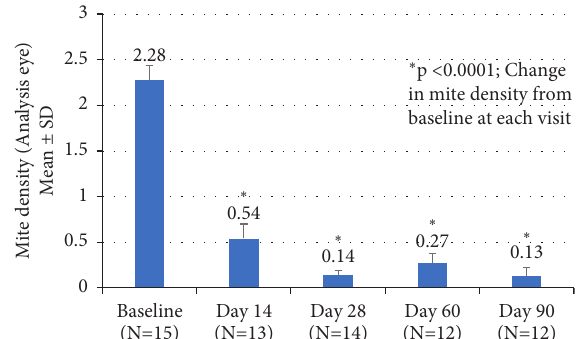
Figure 4: Mean mite density per lash decreased from 2.28 ± 0.16 at baseline to 0.14 ± 0.05 on Day 28 ( p < 0 . 0001 ) in the analysis eyes. The improvement was maintained through Day